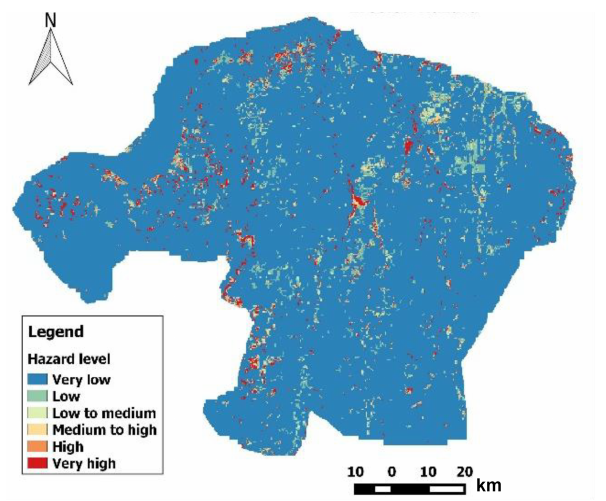
Figure 4. The spatial variation of soil loss potential. Figure 5. The spatial variation of soil erosion